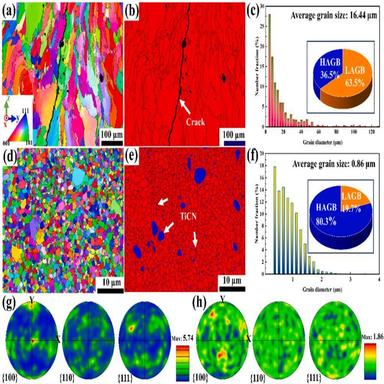
EBSD analysis for (a-c, and g) the as-built pure 2024 Al alloy, and (d-f, and h) the as-built 2024-5 vol% TiCN, (a, d) IPF maps, (b, e) the corresponding grain boundary maps, (c, f) grain size distribution maps with misorientation angle distribution insets, and (g–h) the corresponding pole figures.